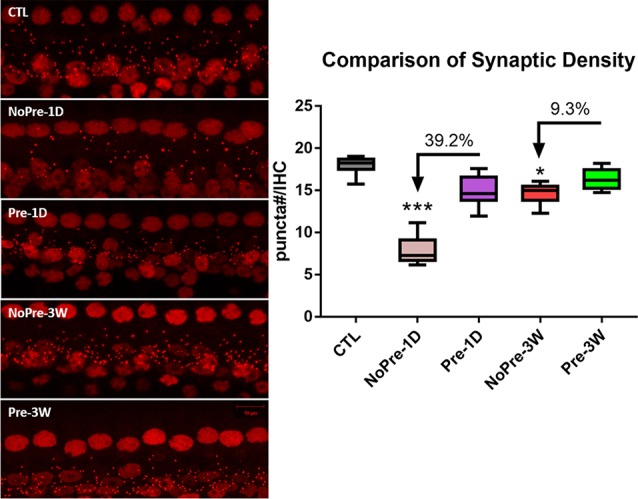
Comparison of synapse counts across groups. Left: representative images of cochlear surface preparation showing presynaptic puncta stained with a CtBP2 antibody. The ribbon puncta were shown as the small red dots. All images were taken from 16 kHz regions. Right: the comparison of the synaptic density averaged across 8–32 kHz regions. The number of ribbon puncta represents the number of synapses, and the synaptic density was calculated as the # puncta/IHC. CTL, control group; 1D, 1-day post-high-level noise; 3W, 3 weeks post-high-level noise; NoPre, group without pre-exposed; Pre, the group with pre-exposed; The between-group comparison was done at 1 day and 3 weeks after the damaging noise, for the evaluation of both temporary and permanent synaptic loss respectively, by using post hoc pairwise comparison (Tukey method) after one-way ANOVA. The number of asterisks represents the level of significance: ***p < 0.001, *p < 0.05.